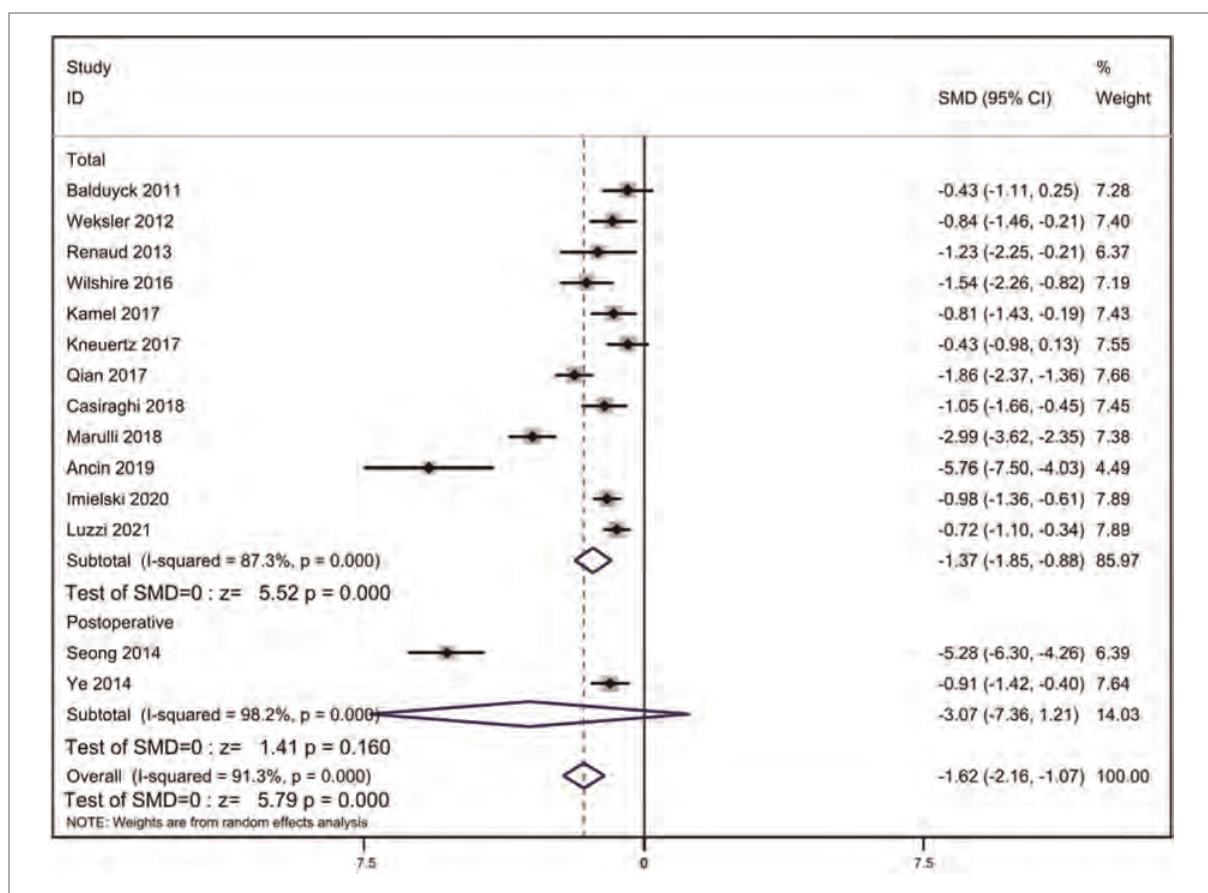
FIGURE 7 Comparison of hospitalization time between RATS and ST. SMD, standardized mean difference; CI, con fi dence interval; RATS, robot-assisted thoracoscopic surgery; ST,